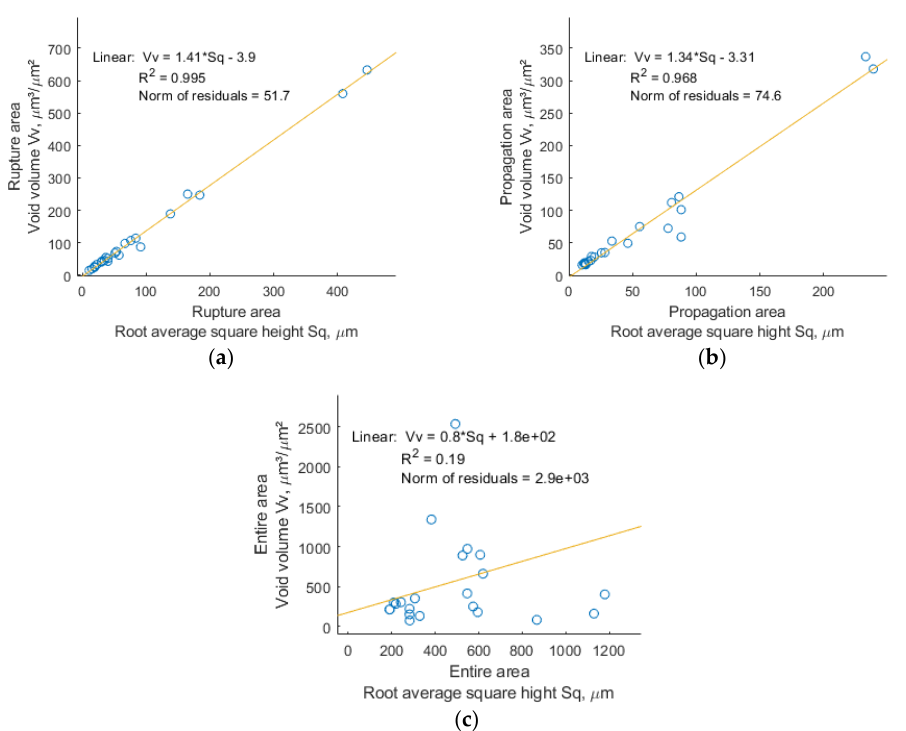
Figure 10. Relationship between void volume Vv and Sq parameter values: ( a ) rupture area; ( b ) propagation area; ( c ) entire area.